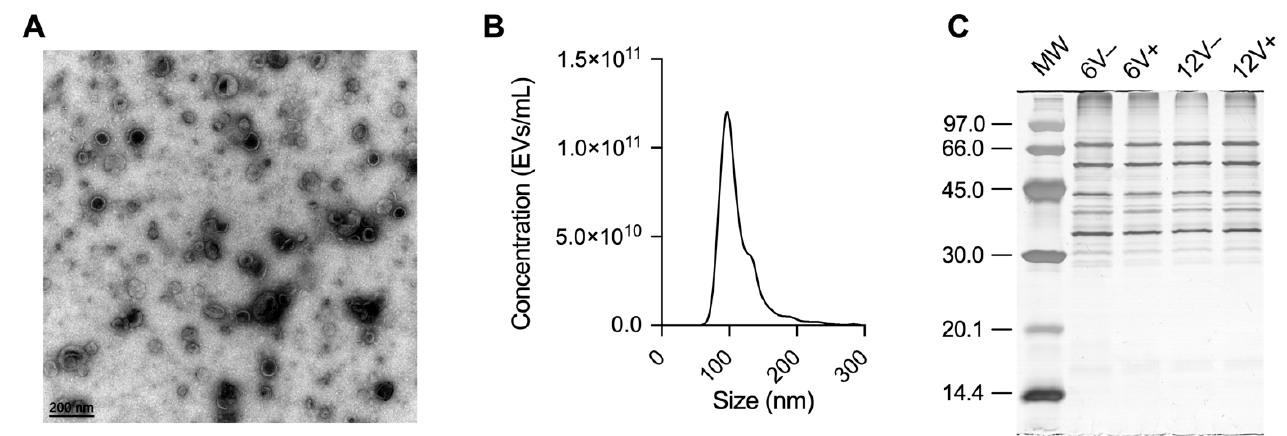
Figure 1. S. aureus HG003 EV characterization. ( A ) Cup-shaped EVs by transmission electron microscopy (TEM). ( B ) Monodisperse profile revealed by nanoparticle tracking analysis (NTA). ( C ) Protein profile of EV samples resolved in 12% SDS-PAGE. Molecular weight (MW) standards are indicated in kDa. Early- and late-stationary growth phases (6 and 12 h, respectively) in the absence (V − ) or presence (V+) of vancomycin.